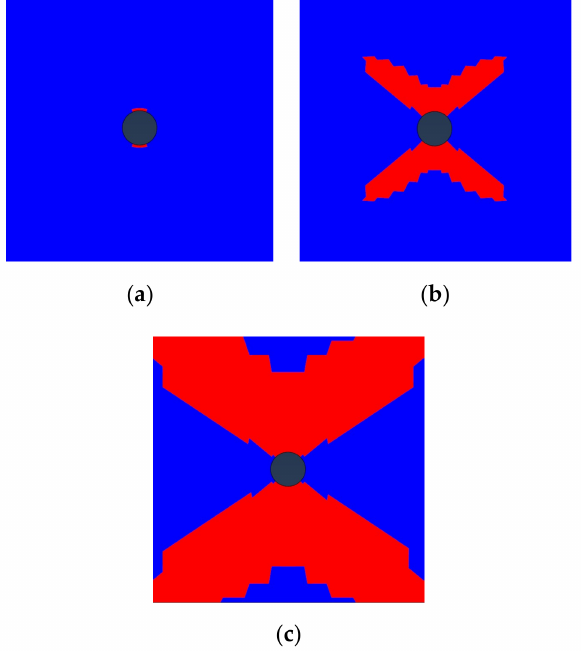
Figure 9. Damage and failure paths in 45 ◦ layer of laminated plates using the GMC/Tsai–Hill method ( a ) Initial damage; ( b ) damage at 90 percent failure; ( c ) damage at ultimate